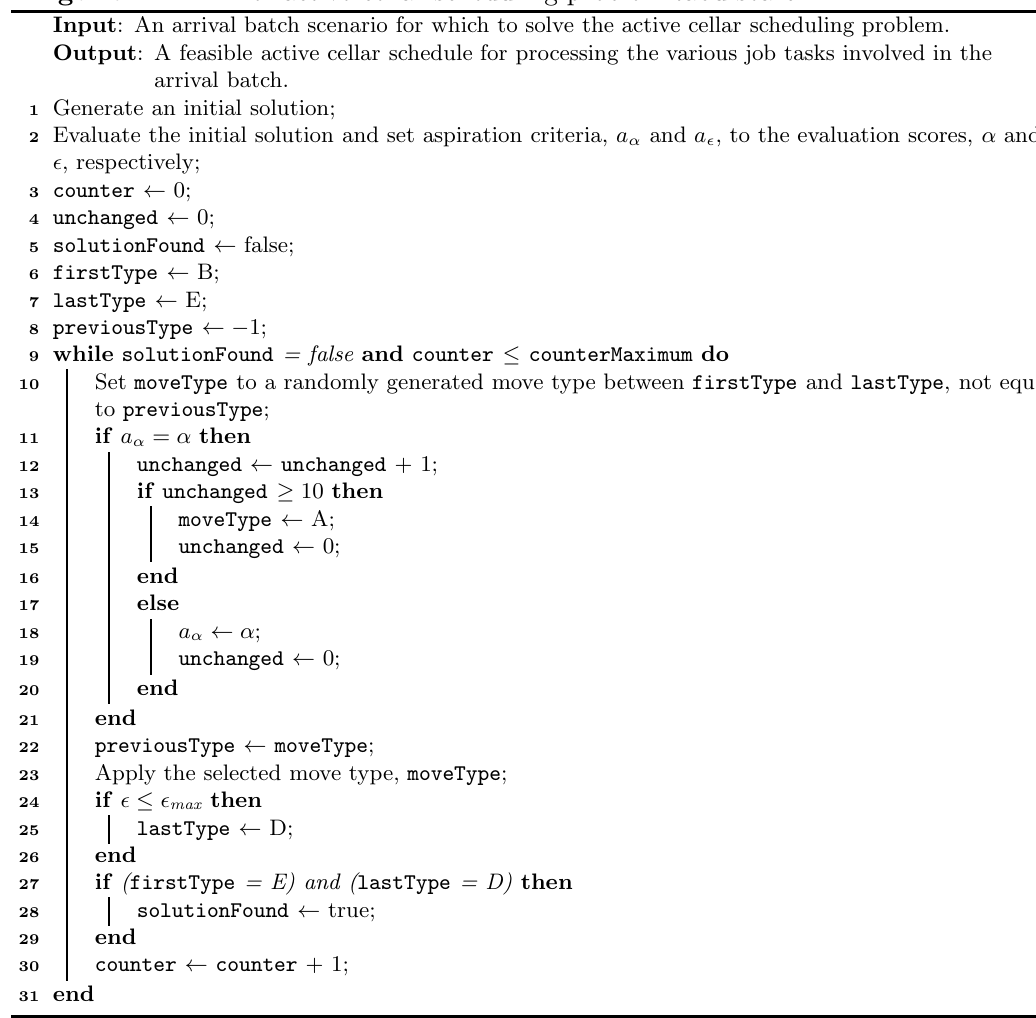
Algorithm 1: Inner active cellar scheduling problem tabu